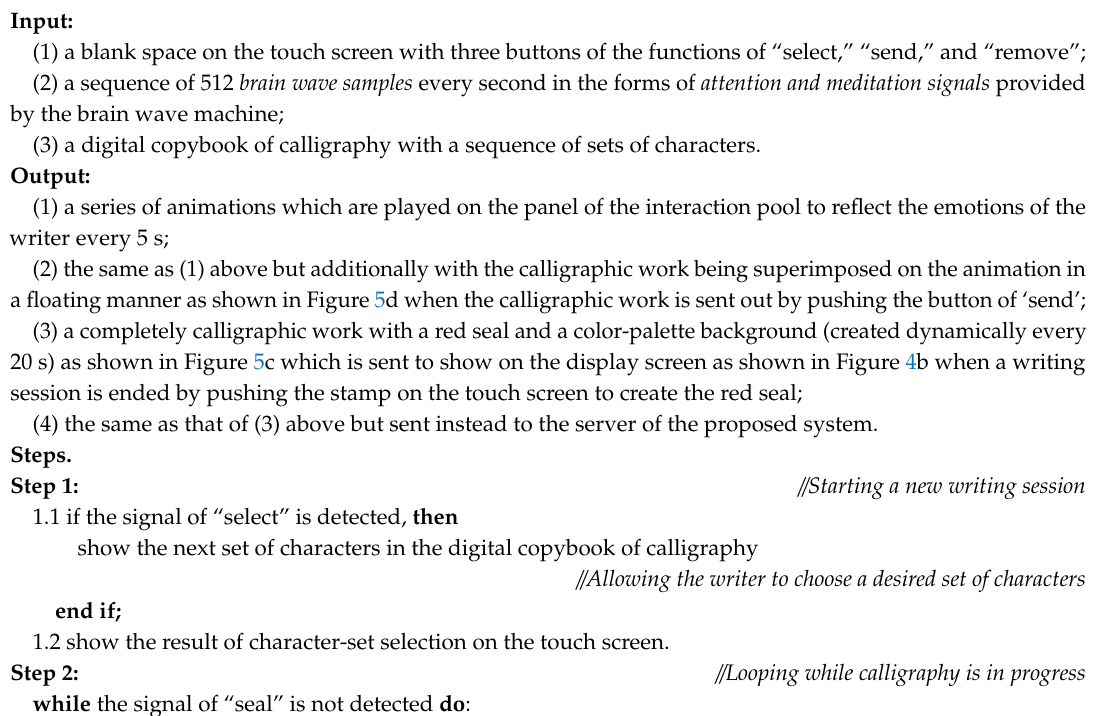
Algorithm 3 The interaction mechanism of the proposed